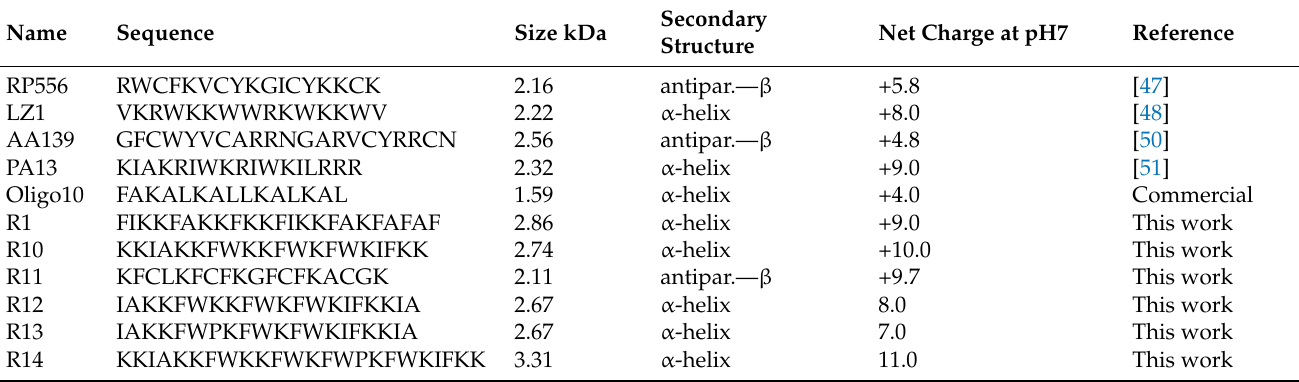
Table 1. Antimicrobial peptide names, corresponding sequences, size, theoretical secondary structure according to APPTEST [52], net charge at pH7, and origin.